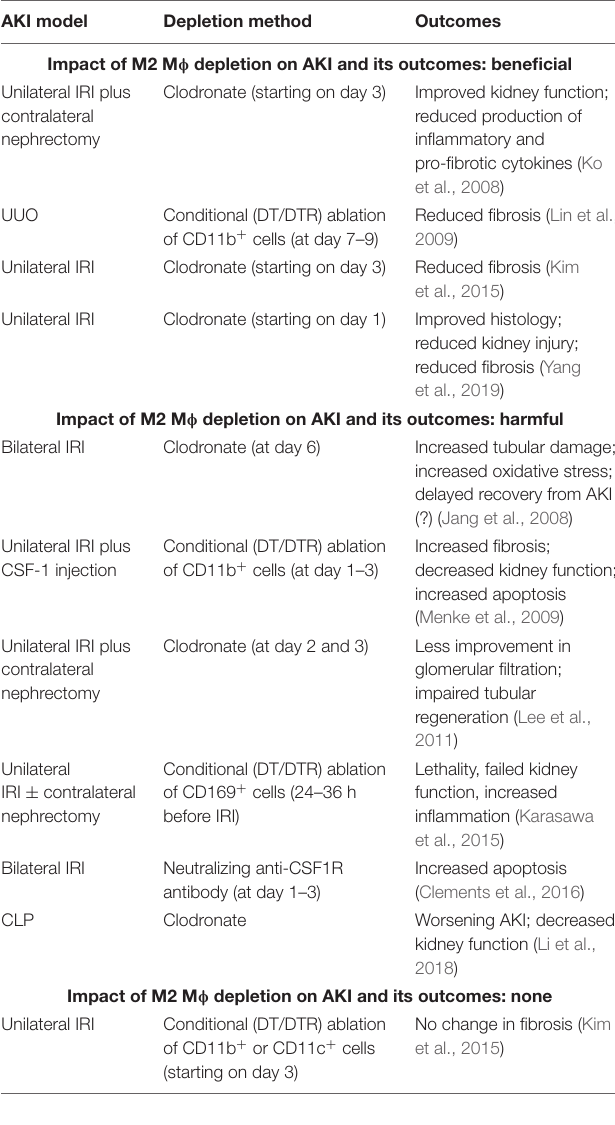
TABLE 3 | Impact of M2 M φ depletion on AKI and its